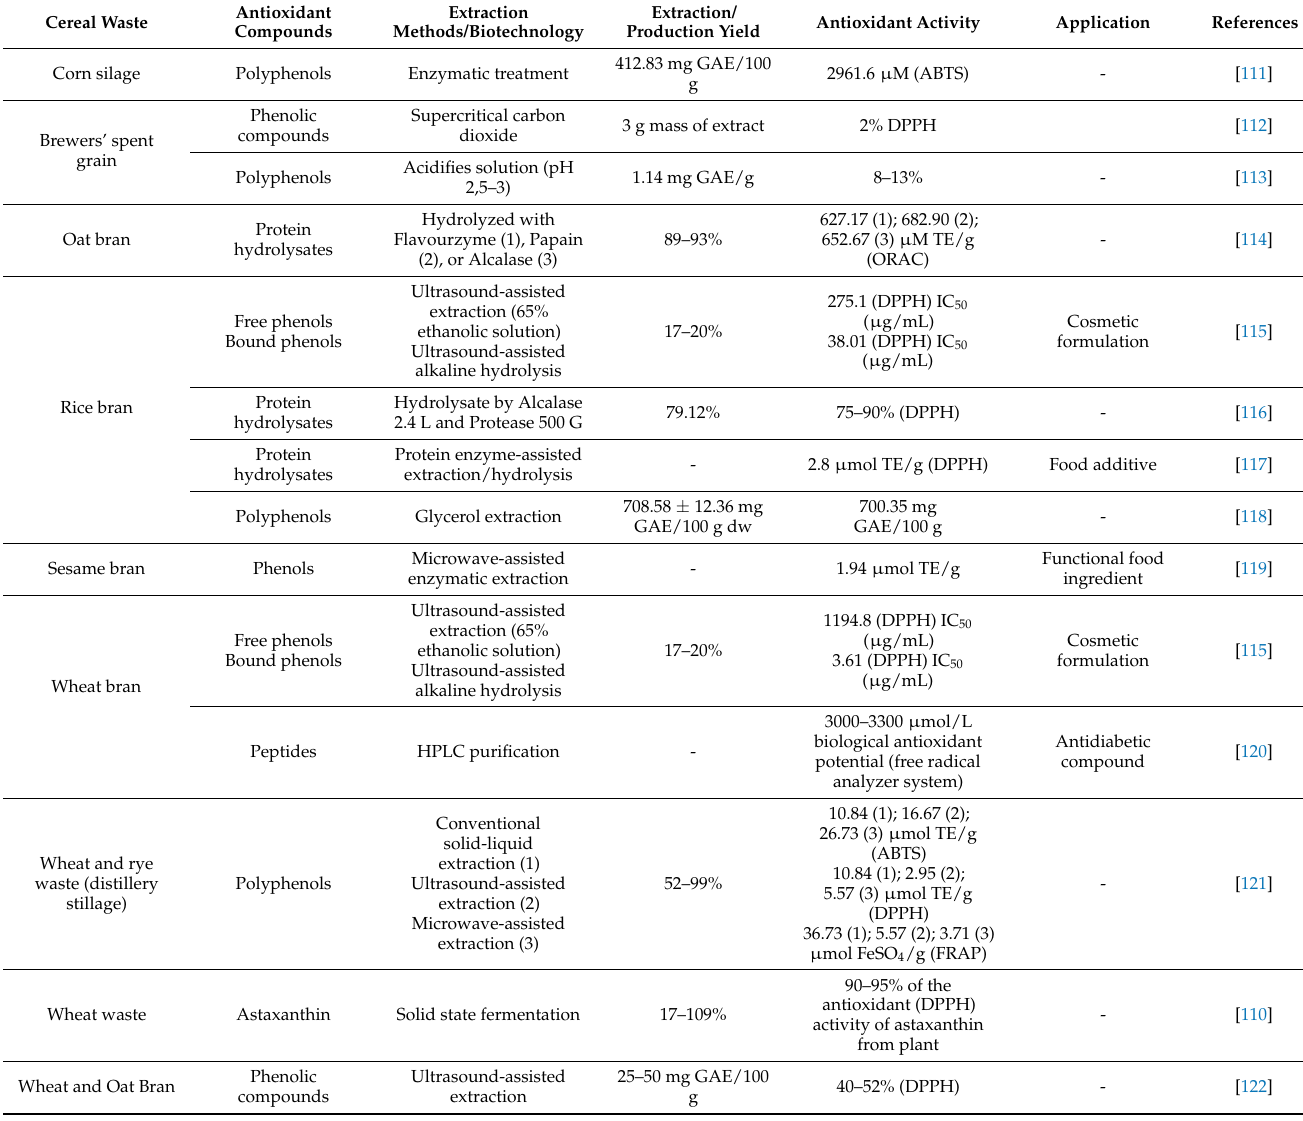
Table 4. Antioxidant compounds recovered from cereals wastes and